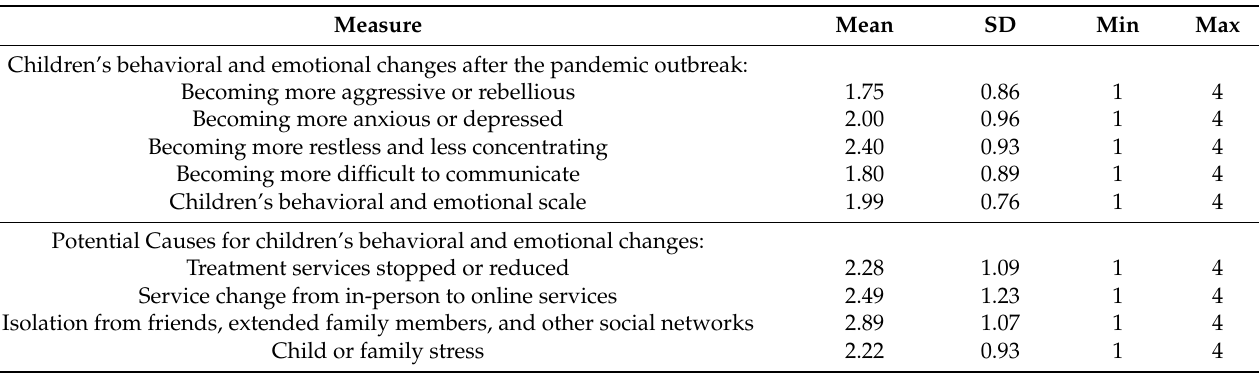
Table 3. Children’s behavioral and emotional changes after the pandemic outbreak and their potential causes ( n =